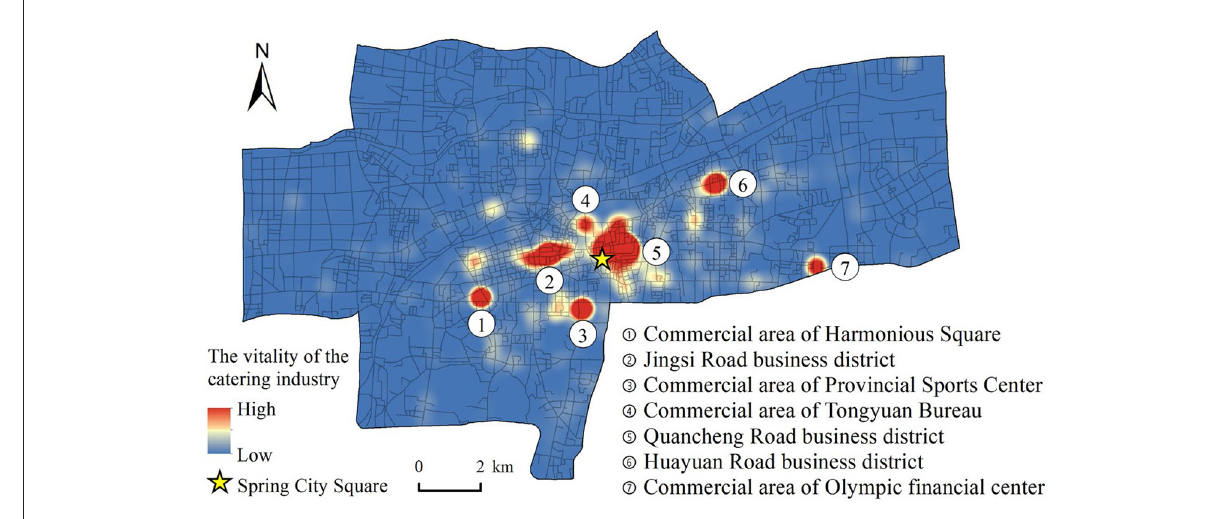
FIGURE2 Main business districts and KDEs of the catering